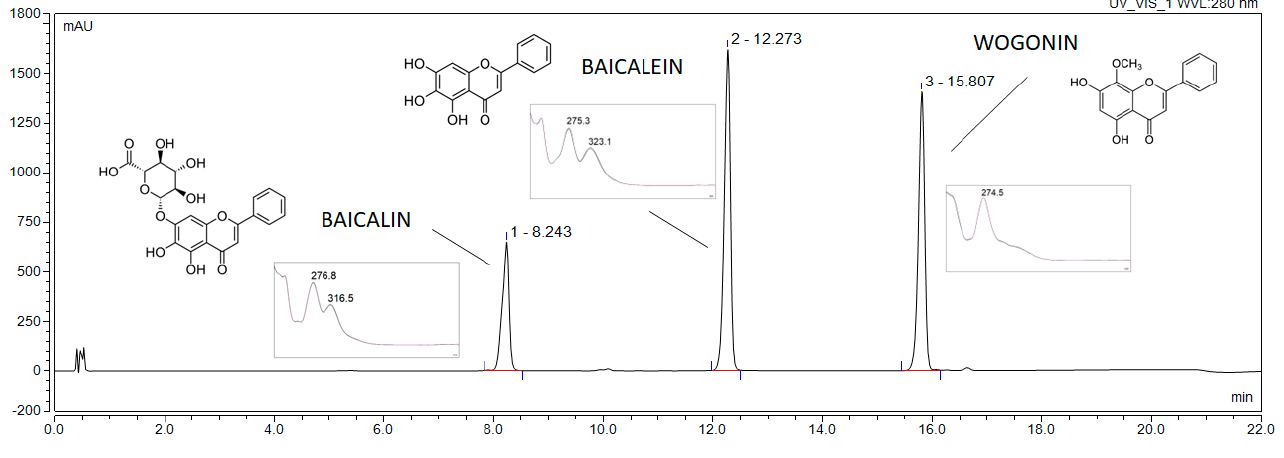
Figure 1. Chromatogram of standards.